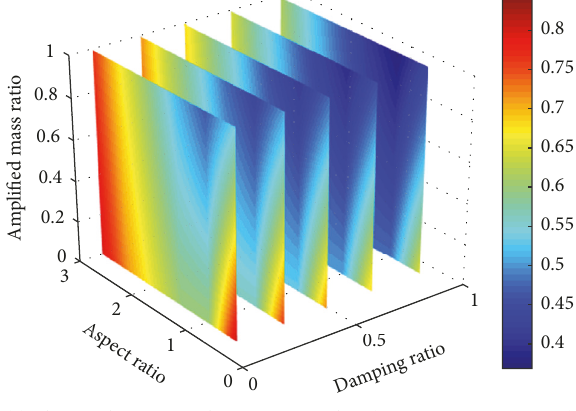
(a) Slices at the constant amplified mass ratio values ( 𝜇 𝑚 = 0.1 , 0.3, 0.5, 0.7, 0.9)